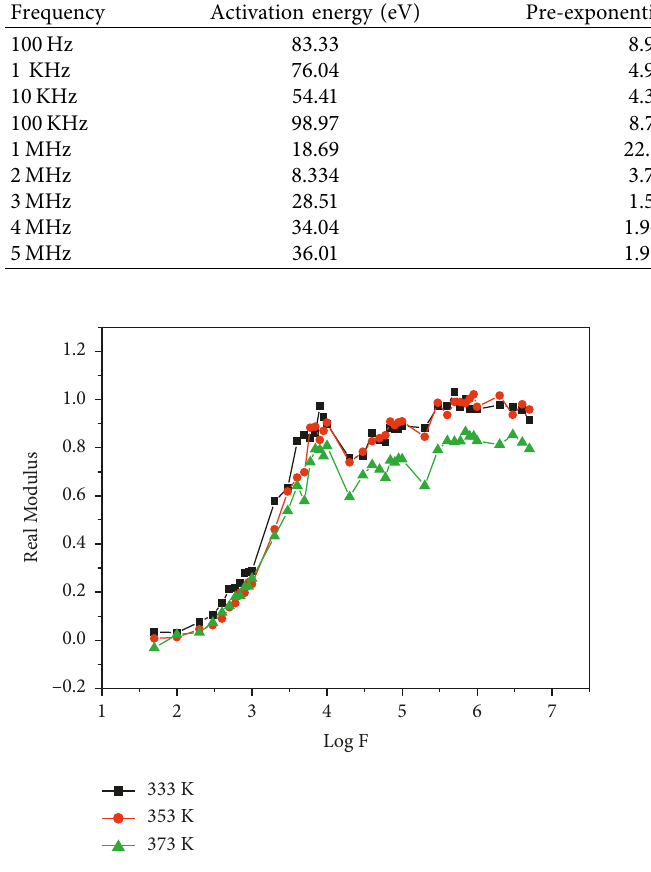
Figure 11: Real modulus vs log F.